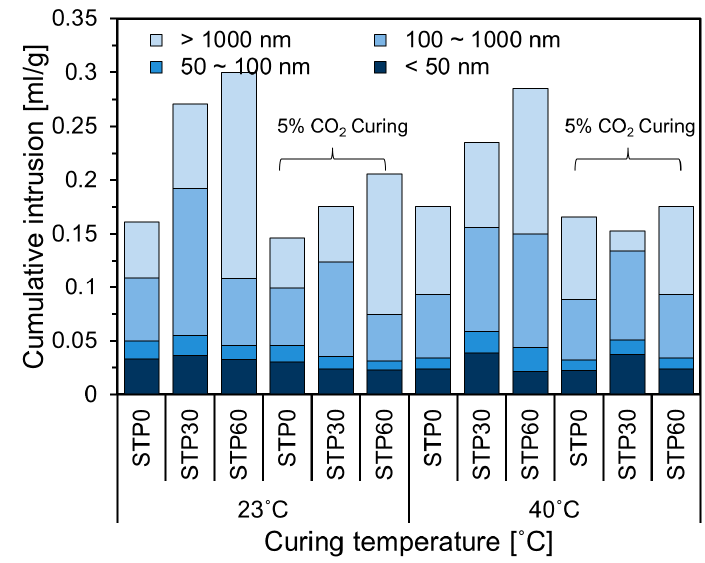
Figure 10. Cumulative intrusion for specimens according to curing temperature.